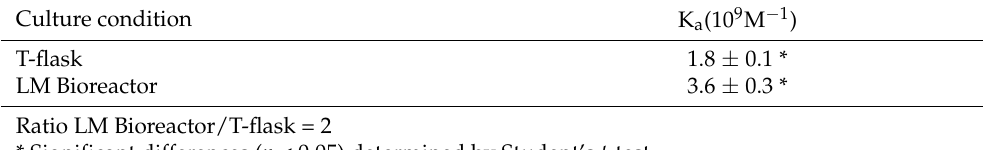
Table 1. Anti-hlFN- α 2b affinity constant (K a ) evaluation in T-flask and LM Bioreactor. Culture